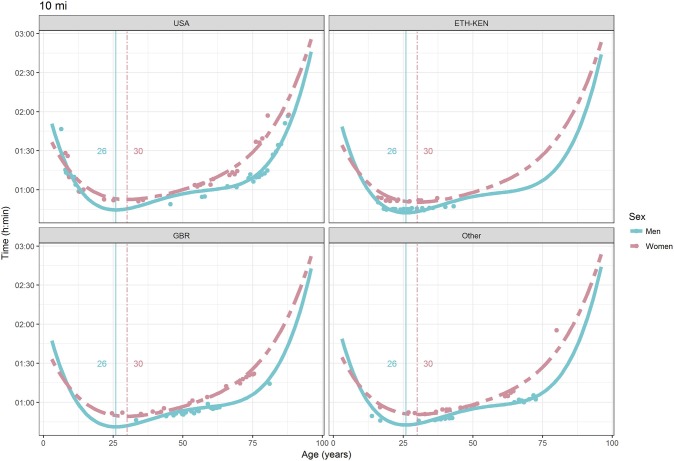
World record in 10 miles by sex, age (in years), and country. Points were observations. Curves represented quartic degree polynomial regression. Vertical lines with numeric labels were the ages at peak performance.